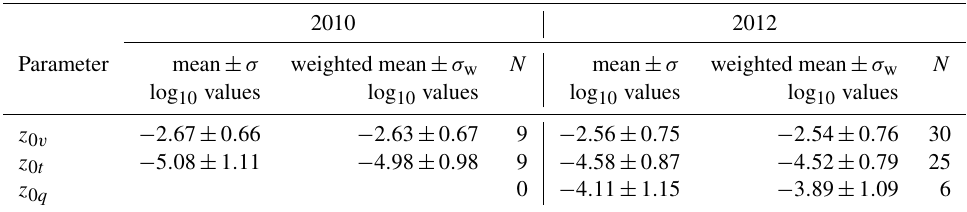
Figure 3. Thirty-minute averages of meteorological variables and SEB fluxes measured at the AWS glac in 2010 (a) and 2012 (b) : near-surface air temperature ( T z ), accumulated precipitation ( P ; measured at AWS low ), wind speed ( U z ), wind direction ( U dir ), incoming ( K down ) and reflected ( K up ) shortwave radiation, and OPEC-derived sensible ( Q H ) and latent ( Q E ) heat flux. Bottom panel shows the OPEC-derived roughness lengths for momentum ( z 0 v ), temperature ( z 0 t ), and humidity ( z 0 q ), after filtering the OPEC data, and their estimated errors. Shaded in blue are the identified time intervals of prevailing katabatic flow (see text). Table 1. Mean and ± standard deviation ( σ ) of log roughness lengths of momentum ( z 0 v ), temperature ( z 0 t ), and humidity ( z 0 q ) derived | < 0 . 1 (cid:1) during 2010 and 2012 observational periods (units are in m). Also shown is weighted for near-neutral stability conditions (cid:0) | z L mean ± standard deviation ( σ w ; see text) and number of points ( N ) used to assess these values, i.e., number of points remaining after all the filters have been applied to the original